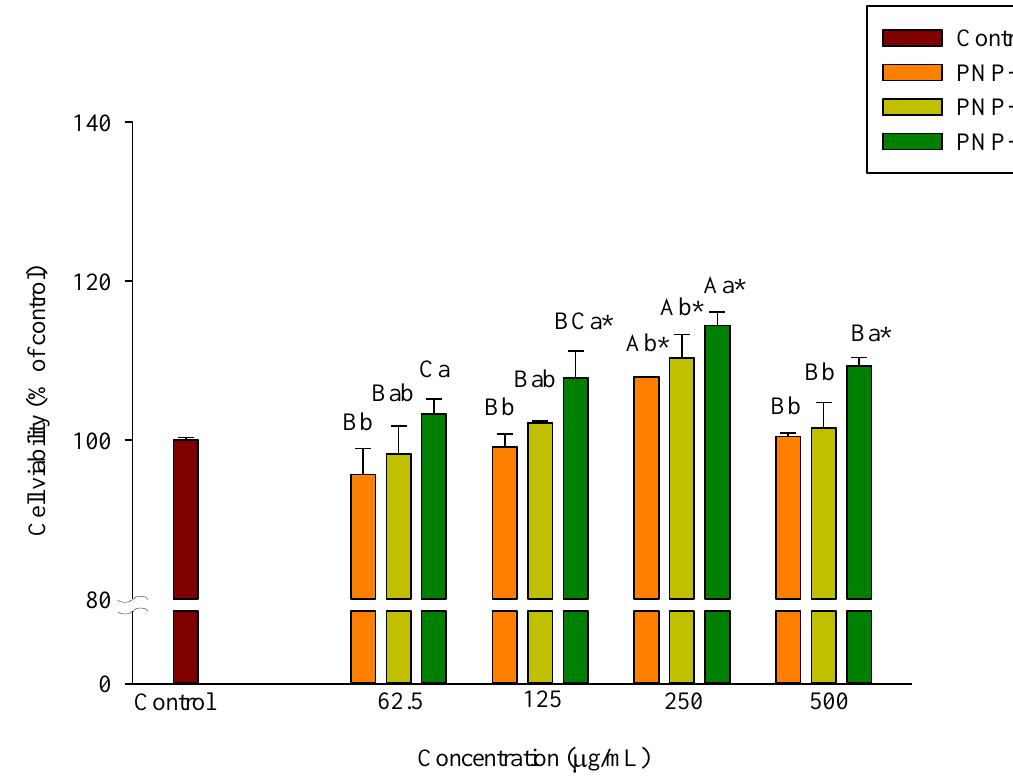
Figure 2. Cell viability analyzed via MTT assay. Cell viability was assessed using 3-(4,5-dimethylthiazolyl-2) 2,5 diphenyltetrazolium bromide (MTT) assays. Hs68 cells were treated with PNPs for 24 h. Experiments were conducted in triplicate ( n = 3). Data are expressed as the mean ± SD. * Significant differences compared to the control group ( p < 0.05). a,b: Matching lowercase letters between samples at the same concentration indicate significant differences between the samples at that concentration ( p < 0.05). A–C: Matching uppercase letters for the same sample at different concentrations indicate significant differences for that sample between different concentrations ( p <